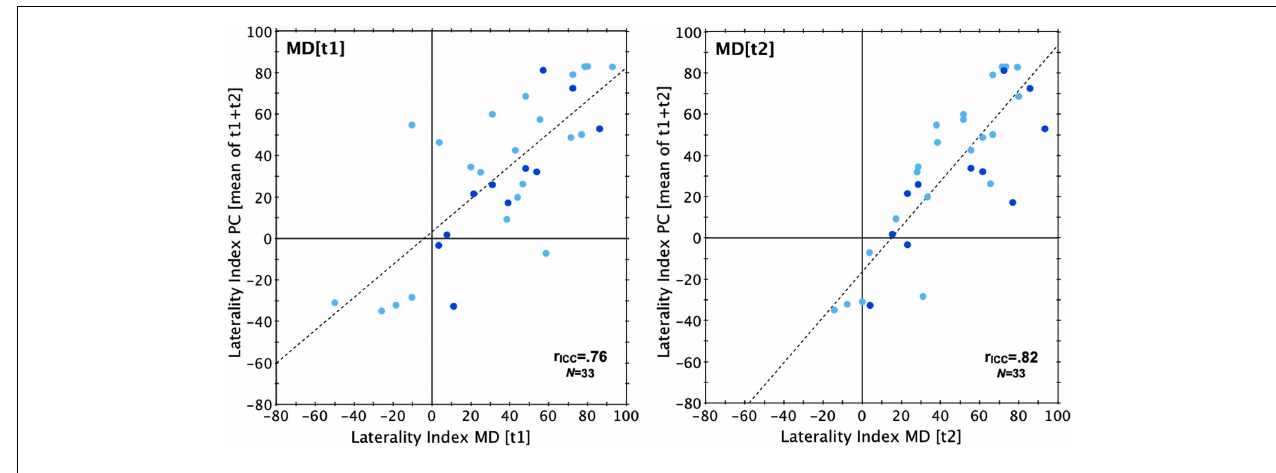
difference between correct LE and RE reports. r ICC , intraclass correlation coefficient. Dot color indicates sex: light blue, females; dark blue, males.